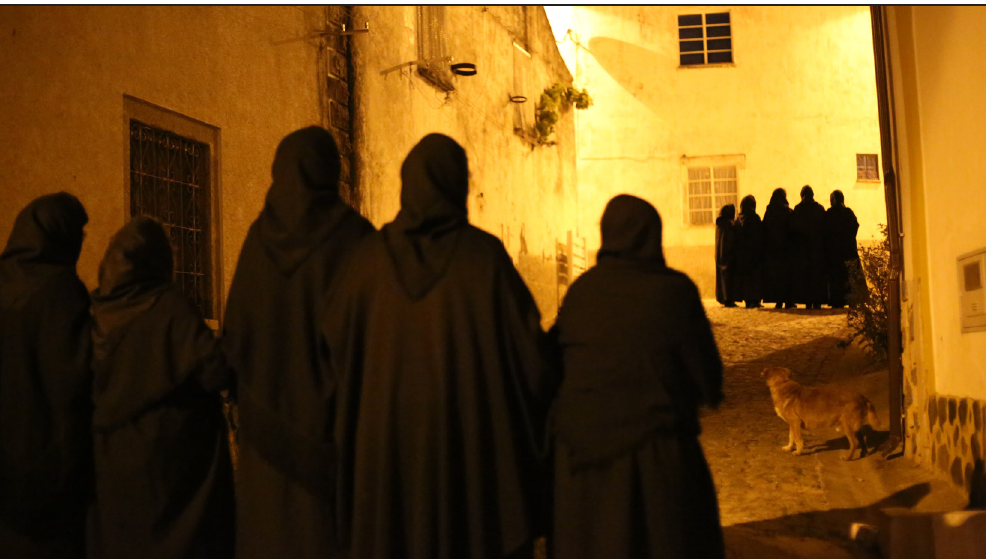
Figure 2: In the Lenten repertoire of Monfortinho, the majority of the rituals are carried out through a nocturnal walk in the alleys, in which two groups get involved in sequences of responsorial singing. The Commending of the Souls was here articulated together with the Martyrs of the Lord, in a combined performance. (Photo: Pedro Antunes,